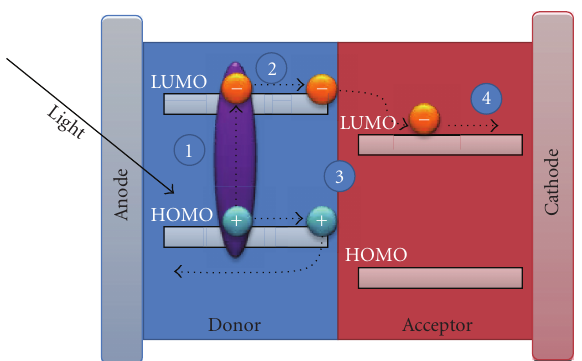
Figure 1: Scheme of operative sequence of an